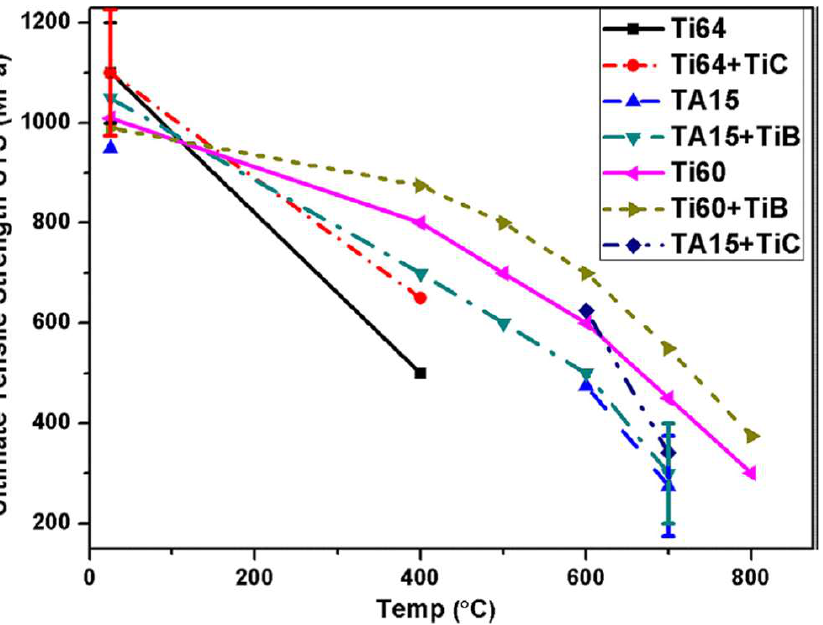
Figure 4. General overview of the UTS over a temperature range for different SiC fibre-reinforced composites [53–59].